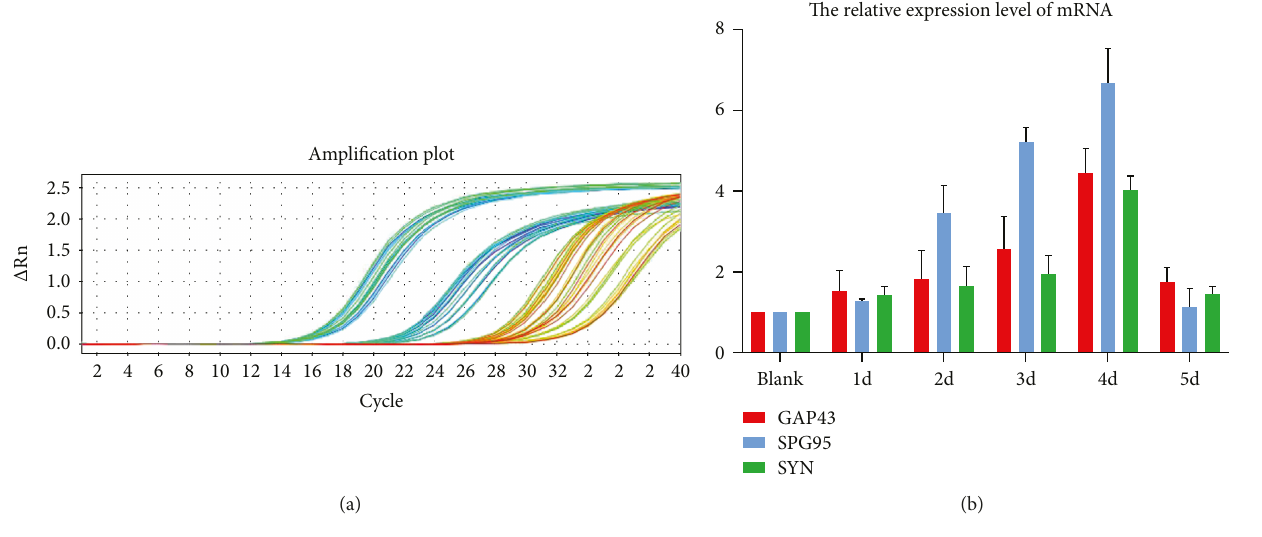
Figure 9: (a) Result of Real-Time PCR. (b) Relative expression level of